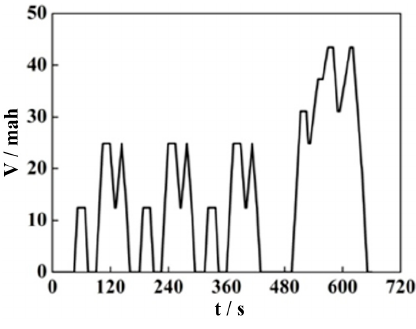
Figure 8. 1015 driving cycle. Energies 2020 , 13 , x FOR PEER REVIEW